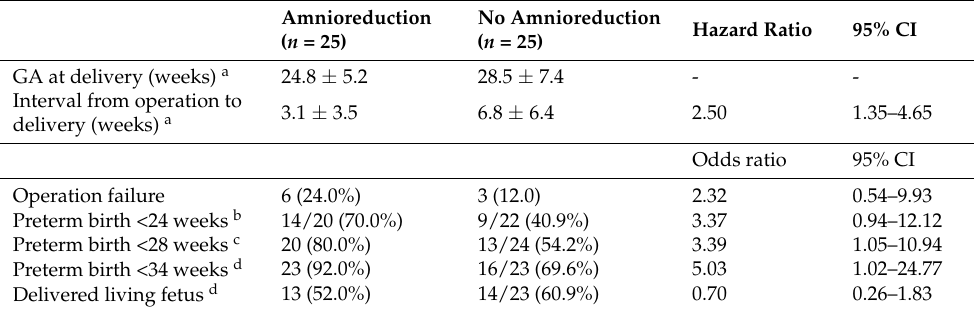
Table 2. Obstetric outcomes of propensity score-matched population.